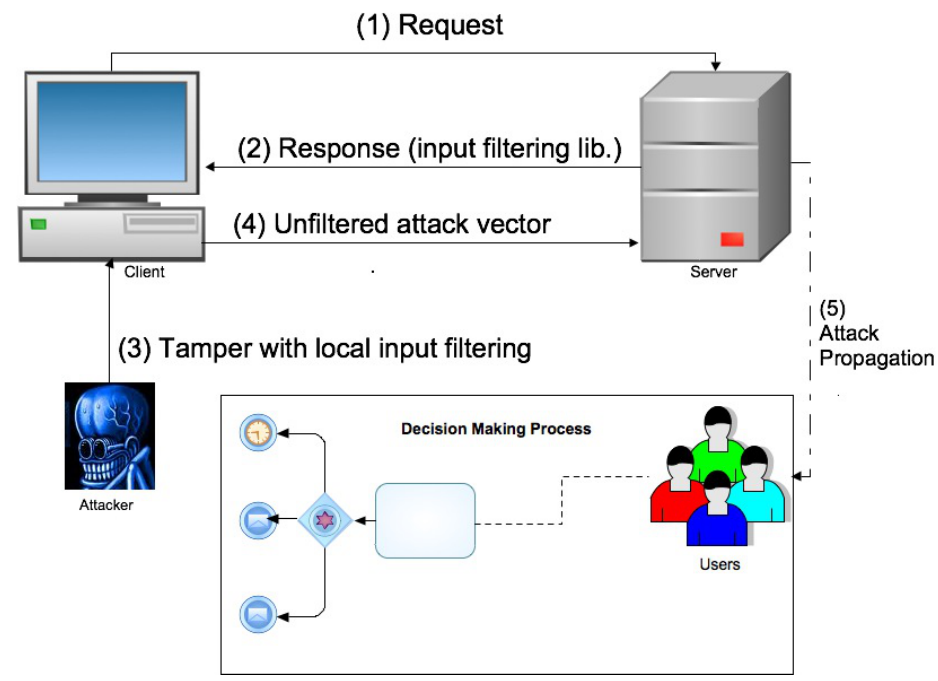
Figure 3. Example of Web 2.0 Attack on decision making process